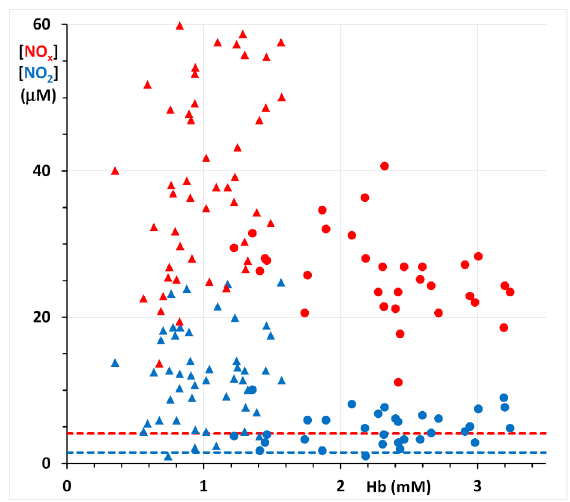
Figure A1. Concentrations of nitrite (blue symbols) and nitrate (red symbols) in the 48 samples of the Antarctica 2015 subjects (triangles) and in the 32 samples from the breath-hold divers 2019 study (closed dots). Results are reported as the raw concentration in the tested hemolysates, ordered by the increasing concentration of hemoglobin in the employed sample. The blue thick dotted line shows the Lower Limit of Detection (LoD) for nitrite as 1.5 µ M; the blue thick dotted line shows the LoD for nitrate as 4.1 µ M (regression lines of Figure